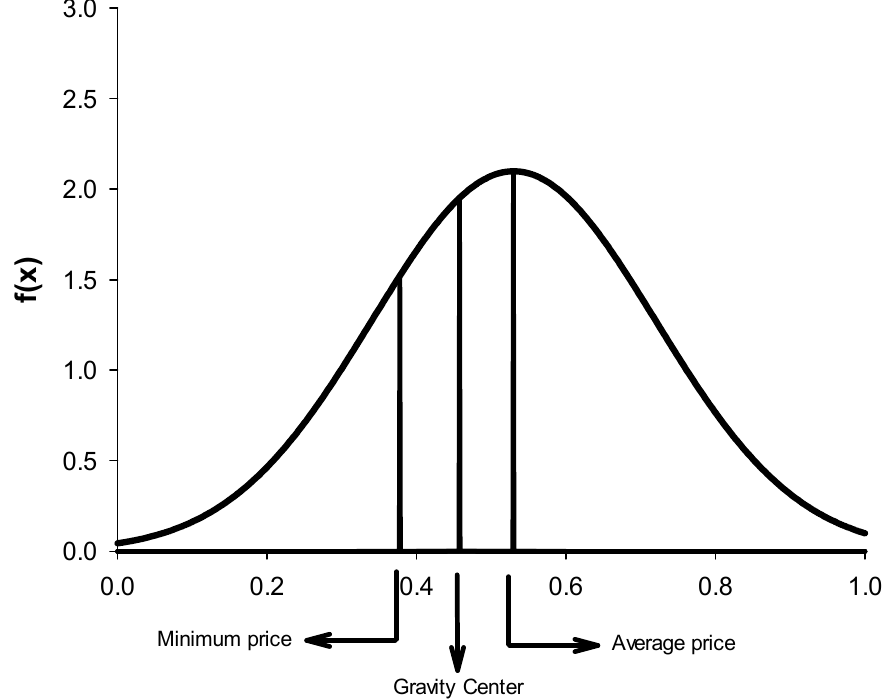
Figure 3. Density function of the prices for week 24 in € kg − 1 . This process is repeated weekly. As to be expected, the probability of the price being between 0.378 € kg − 1 and the weekly mean decreases as the mean prices decrease. This